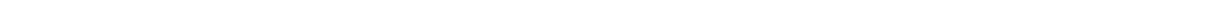
Fig. 5 miR-30 activity increases in Serpine1 -MRE-KO cells. a Scheme representing WT and MRE-KO cells expected behaviour in terms of miR-30c activity with canonical targets (in blue) and decay targets (in red). When TDMD is suppressed (i.e., by removing the MRE from a TDMD target, like Serpine1), miRNA increases in abundance and is redistributed on targets thus increasing its repression activity. b , c Expression analysis of WT and MRE-KO cells was performed by RNA-seq in different conditions of cell growth (GW: growing cells; 0 h: quiescent cells; 8 h and 12 h: serum-stimulated cells). b Bar charts report the difference between the median log2 fold changes (MRE vs WT) of different subsets of miR-30 targets. The analysis was performed with targets either predicted by TargetScan7.1 (897 conserved targets, CS, also broken down by seed-match as 8-mer, 7-mer-m8, or 7-mer-A1) or validated by HITS- CLIP (1037 targets, from Tarbase v7.0 35 ) and CLEAR-CLIP (1315 targets 36 ). c p -values of data shown in ( b ). d , e Cumulative distribution functions (CDF) of log 2 FC of mRNA (MRE vs WT) for conserved targets (CS), not conserved targets (NCS) and genes not predicted as targets (Other). f , g CDF plot as in ( d , e ) with miR-30 targets from HITS-CLIP experiments 35 . h , i CDF plot as in ( d , e ) with miR-30 targets from CLEAR-CLIP experiments 36 . j , k Targets for all expressed miRNAs were identi fi ed by CLEAR-CLIP. The bubble plots report the median log2 fold changes (MRE-KO vs WT), calculated for every miRNA having at least 50 expressed targets. Colour code is for miRNA families. Members of the miR-30 family are highlighted in green. All statistical analyses (chi-square and p -value) were performed using the Wilcoxon